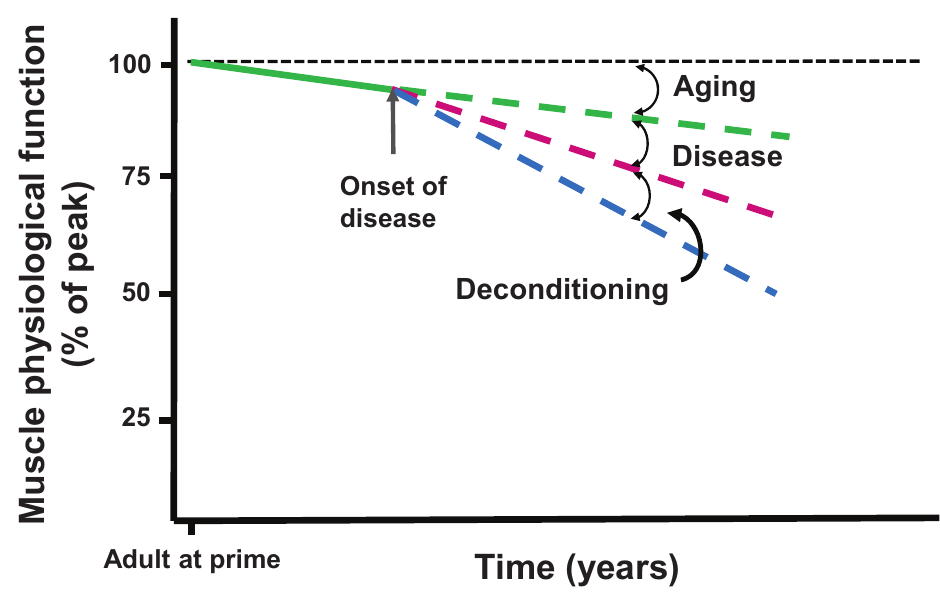
Figure 1. Physiological function (represented here as a composite index of muscle size, strength, and oxidative capacity, relative to maximum) declines with age (green hatched line), to which declines from disease (magenta hatched line) and muscle deconditioning (blue hatched line) produce a cumulative phenotype. The rates of decline in this figure are hypothetical and do not represent actual data. The primary disease effect is simply what the disease would present in the absence of muscle deconditioning. Exercise rehabilitation may partially or fully correct the effect of muscle deconditioning, except in the case of ME/CFS, where standard therapeutic approaches involving exercise may in fact exacerbate the condition. In general, it is not clear whether exercise therapy can also blunt or reverse aspects of the age-related decline in physiological function. While the sensation of fatigue tracks muscle physiological function, the magnitude of the sensation (relative to the maximum experienced) may be proportionally greater than the proportionate loss of physiological